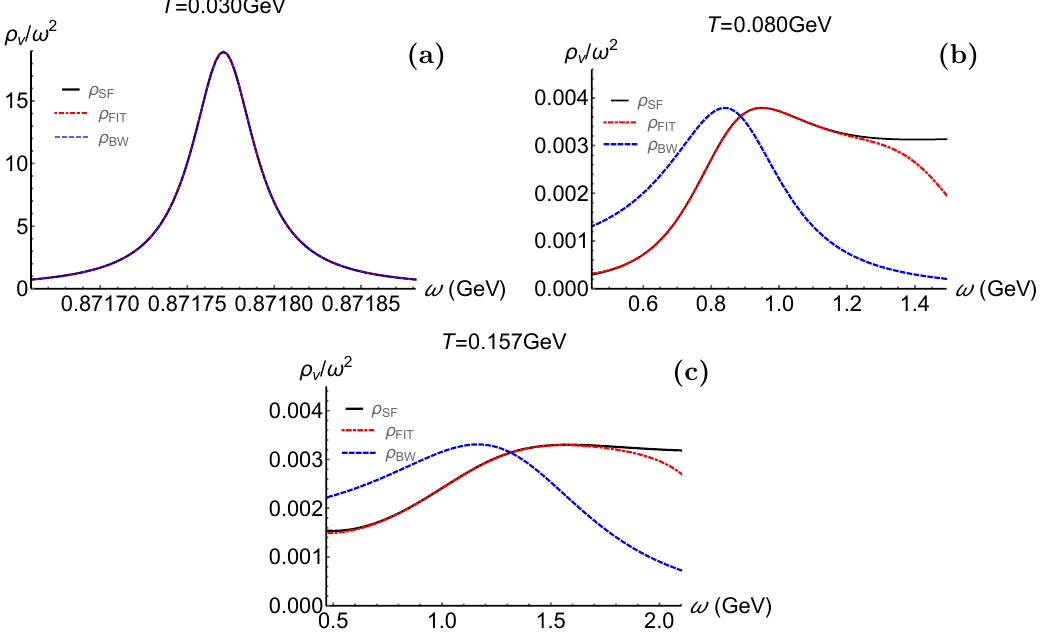
Figure 9 . Comparison among the spectral functions ( ρ SF ), the fitted-spectral functions( ρ FIT ) and Breit-Wigner formula ( ρ BW ) of the vector meson at (a) T = 0 . 030 GeV, (b) T = 0 . 080 GeV and (c) T = 0 . 157